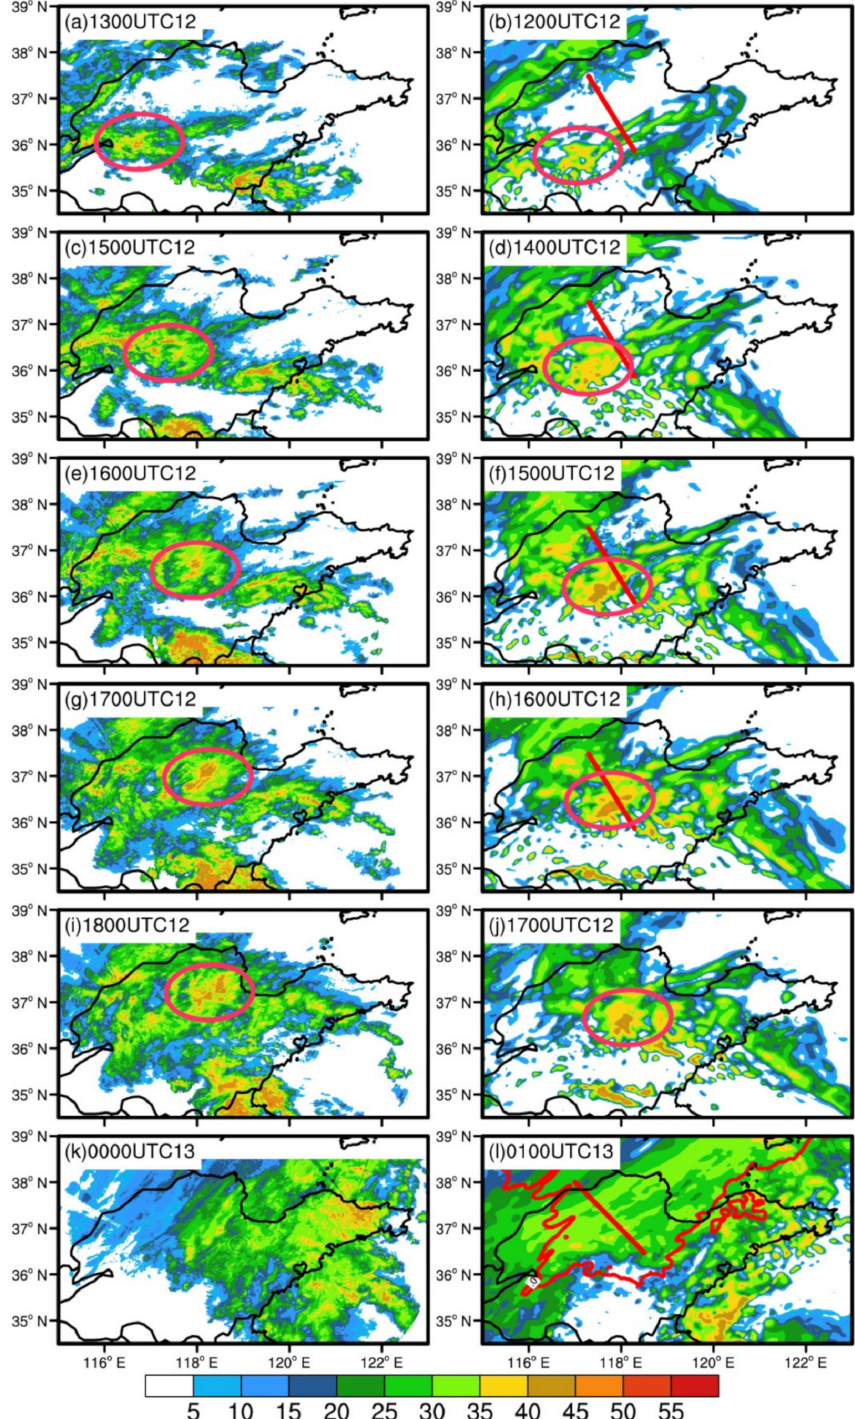
Figure 9. Comparison of radar reflectivity (unit: dBZ) between ( a , c , e , g , i , k ) observations and ( b , d , f , h , j , l ) the 4 km domain simulation at ( a ) 1300 UTC 12, ( b ) 1200 UTC 12, ( c , f ) 1500 UTC 12,